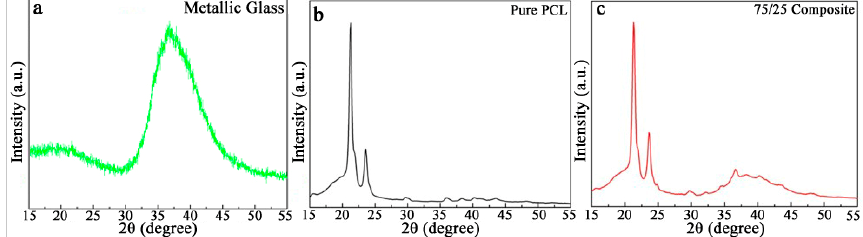
Figure 3. X-ray difraction patterns of the ( a ) metallic glass, ( b ) PCL, and ( c ) Mg 66 Zn 30 Ca 4 /PCL 75/25 composite. 75 / 25